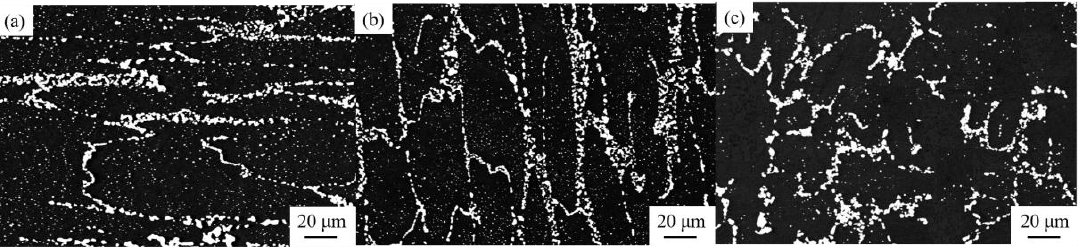
Figure 7. Microstructures of the oil cooling AISI M42 HSS specimens at 1453 K for 15 min ( a ); 30 min ( b ); and 45 min ( c ).